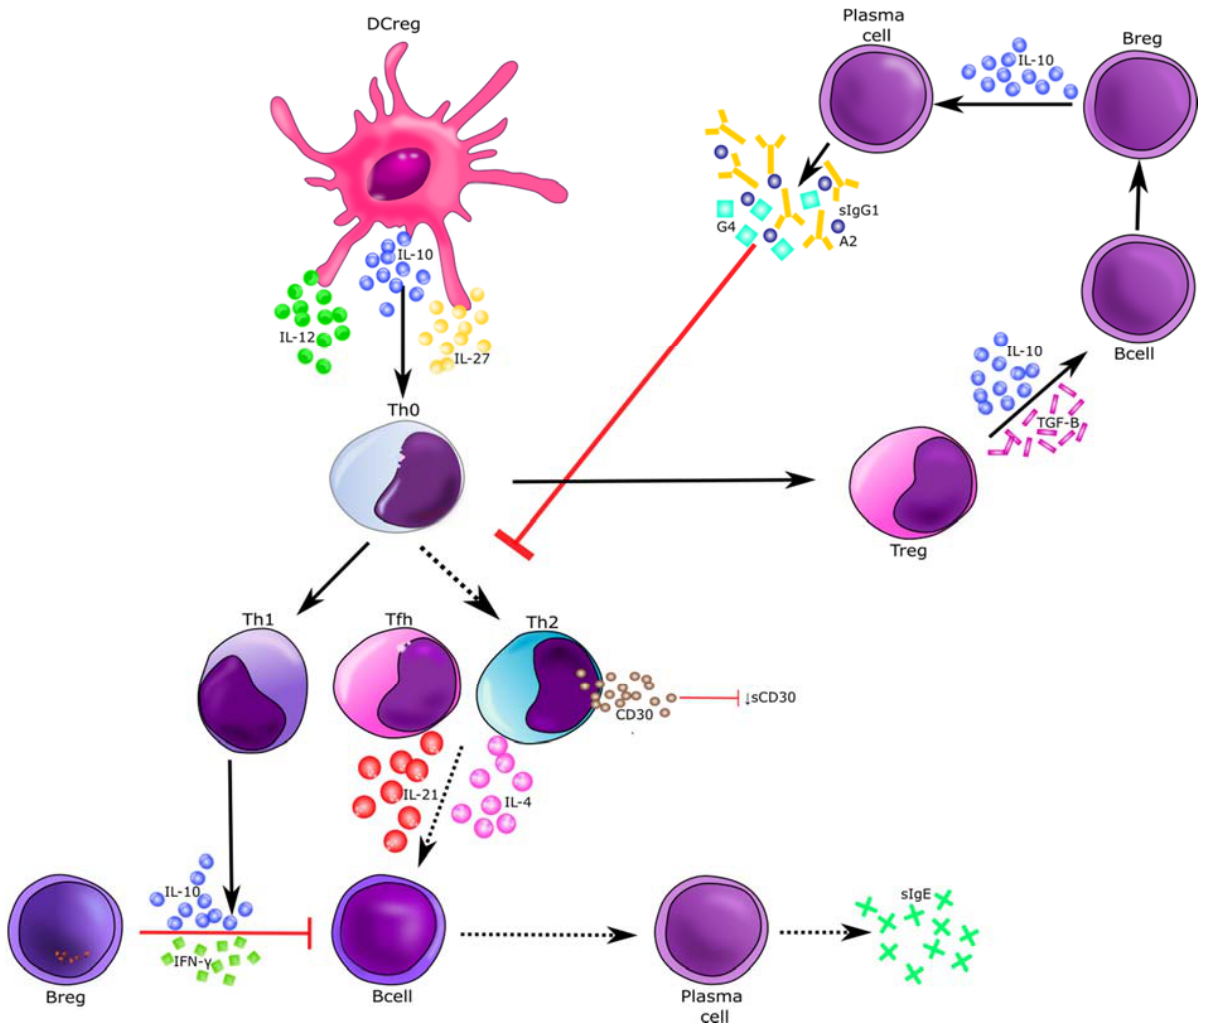
Figure 7. Immunotherapy ‐ induced molecular changes of Hymenoptera venom allergy reaction. Red arrows indicate blocking activity induced during venom allergen immunotherapy. Hymenoptera venom stimulates dendritic cells and induces Treg, B reg, and other B cells to produce allergen specific IgG1, IgG4, and IgA type bloking antibodies that inhibit the activity of Th2 cells. As a result a shift from Th2 to Th1 type immune deviation occurs. Decrease of Th2 cells level is associated with lowering the expression of CD30 molecules on their surface and consequently leads to reduction of sCD30 in serum [31]. sCD30—soluble CD30; Treg—T regulatory cells; B reg—B regulatory cells; Tfh—T follicular hepler cells; DC reg—regulatory dendritic cells; Th1—T helper 1 cells; Th2—T helper 2 cells.